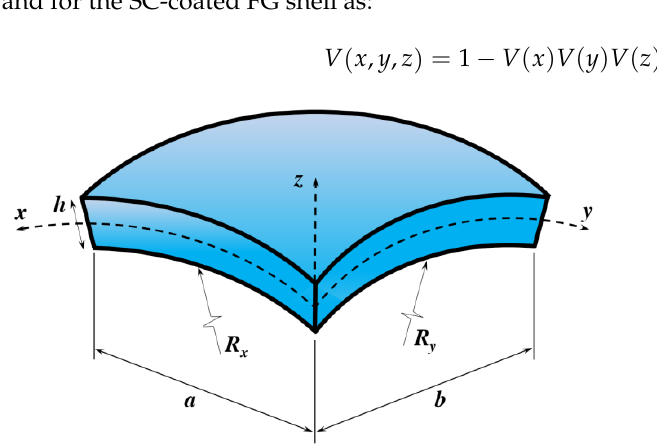
Figure 1. FG spherical shell geometry.